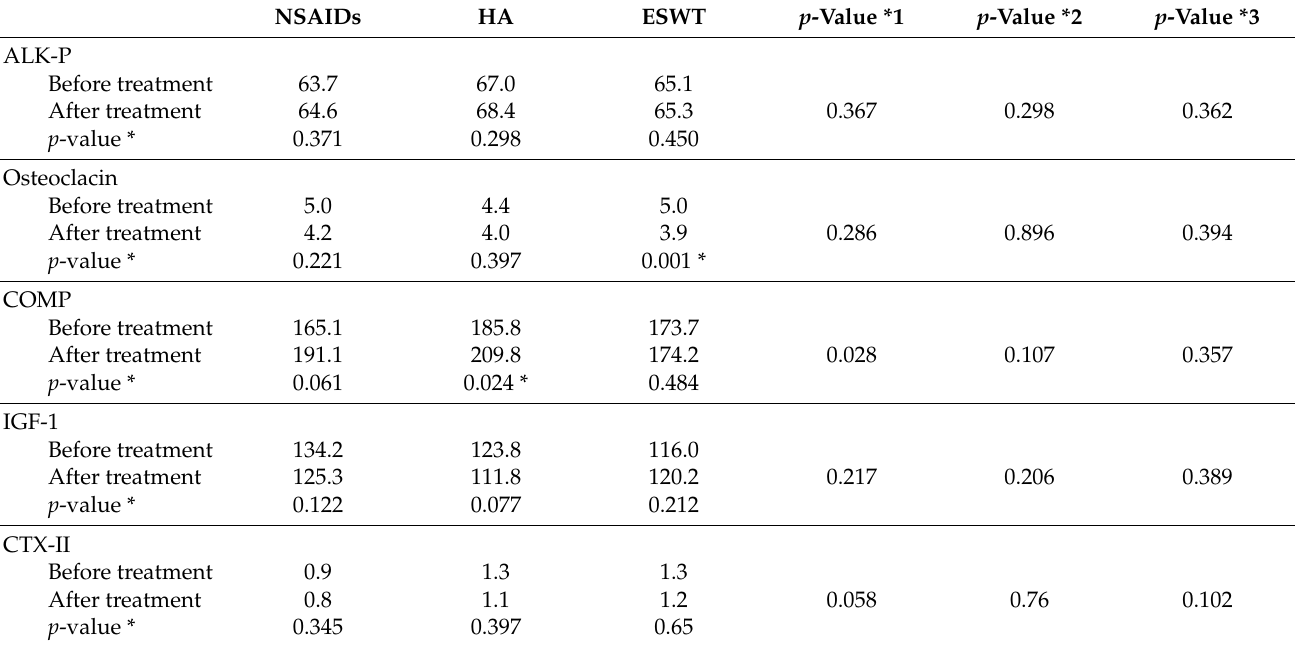
Table 3. The results of blood tests between three groups before and after